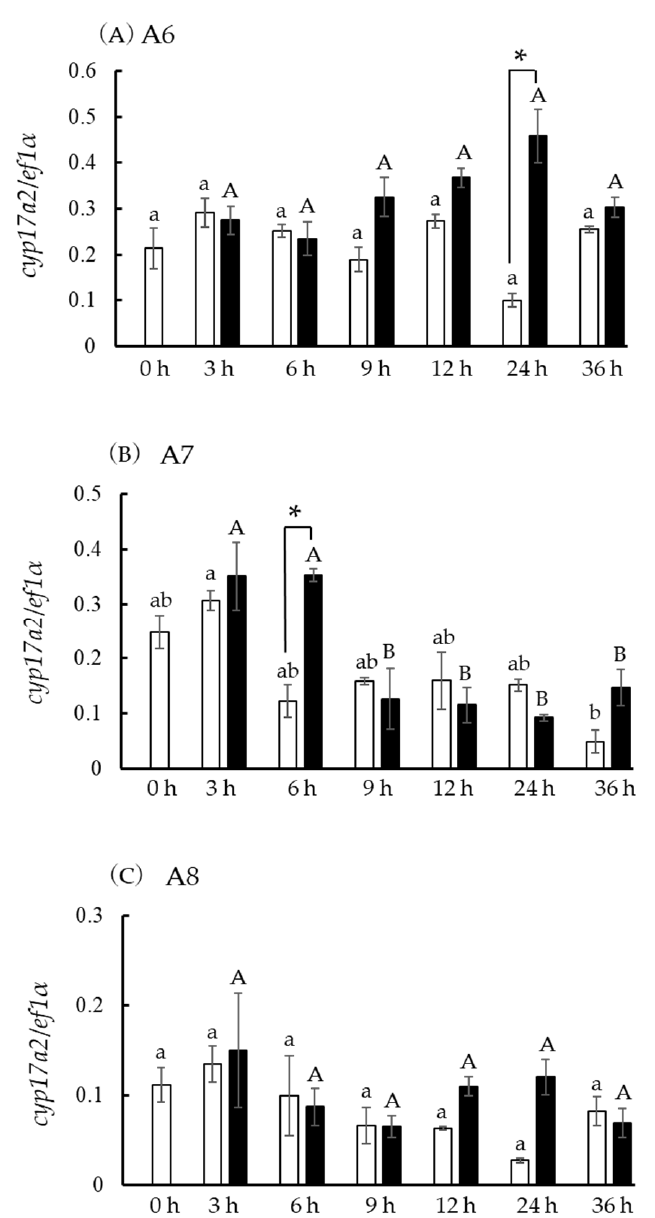
Figure 11. cyp17a2 expression in incubated ovarian follicles from A6, A7, and A8. Levels of mRNA from follicles incubated in media alone (white column), and in 500 µ g/mL SPE (black column). Panels ( A – C ) indicate individuals A6, A7, and A8, respectively. Ovarian follicles from A6, A7, and A8 were used at 8 h after injection of LHRHa. Each vertical bar represents the mean ± SE of three replicate incubations. Different letters (control: a, SPE: A) represent a significant difference among groups ( p < 0.05). * p < 0.05.